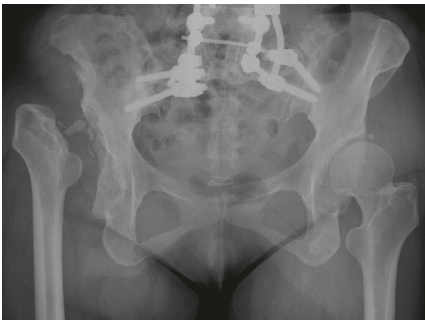
Figure 1: Case 1 preoperative hip X-ray. Right Charcot arthropathy of the hip shows typical radiographic